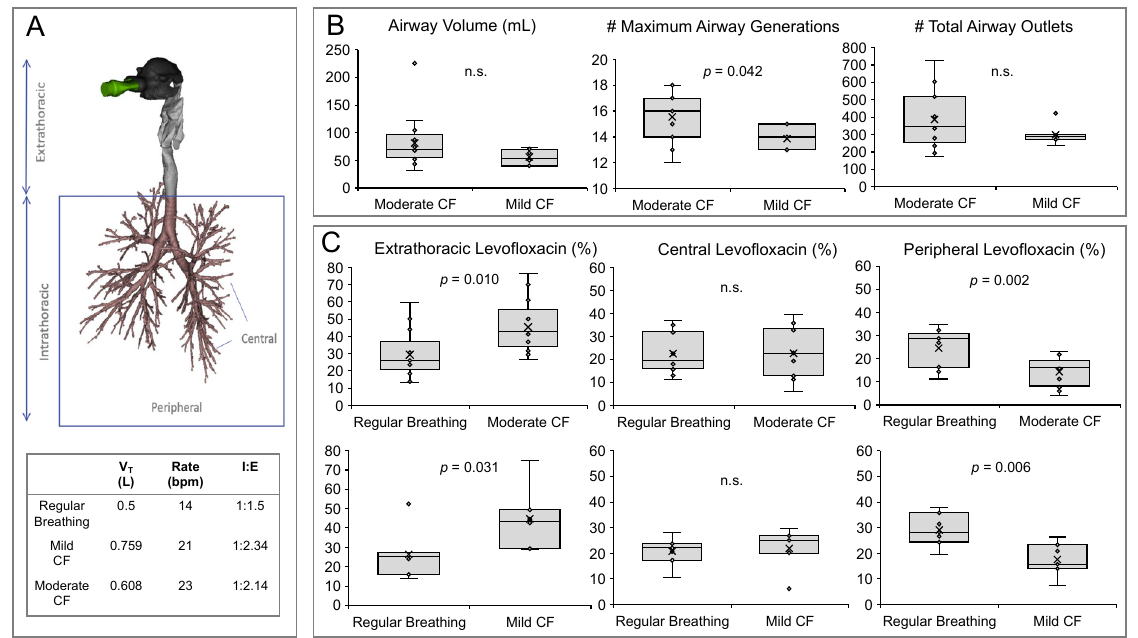
Figure 2. ( A ) Representative three-dimensional rendering from a high-resolution computed tomography scan from a cystic fibrosis patient. Different aerosol deposition regions are described in the figure; below, a table summarises the three different breathing patterns used in the study. ( B ) Comparison of the airway volume, maximum airway generation, and total airway outlets determined in mild and moderate cystic fibrosis airways; n.s., non-significant. ( C ) Top row: Extrathoracic, central airway, and peripheral lung deposition of levofloxacin achieved with either the “regular breathing” pattern or the moderate CF breathing pattern in thirteen patients with moderate cystic fibrosis. Bottom row: Extrathoracic, central airway, and peripheral lung deposition of levofloxacin achieved with either the “regular breathing” pattern or the mild CF breathing pattern in seven patients with mild cystic fibrosis; n.s., non-significant.